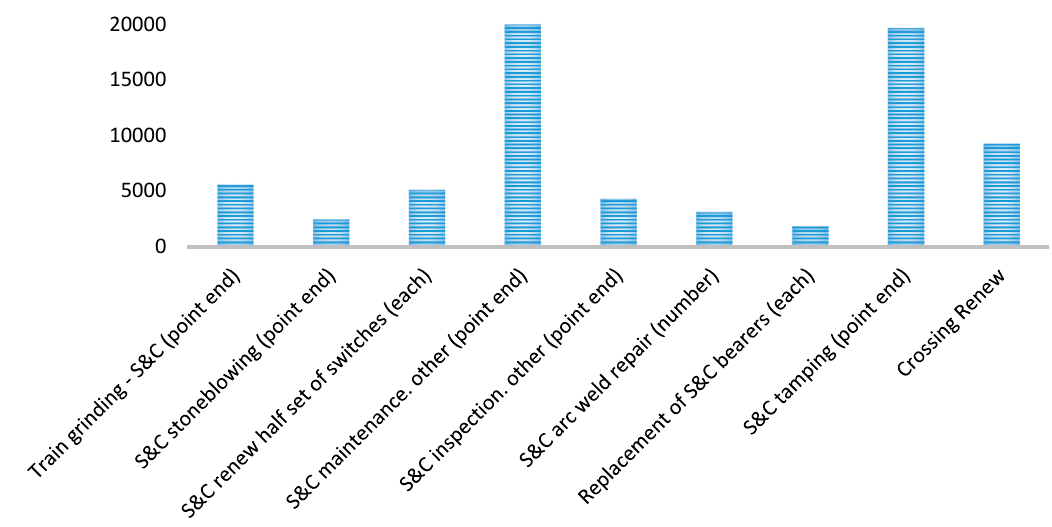
Figure 1. LCC analysis based on the breakdown work structure